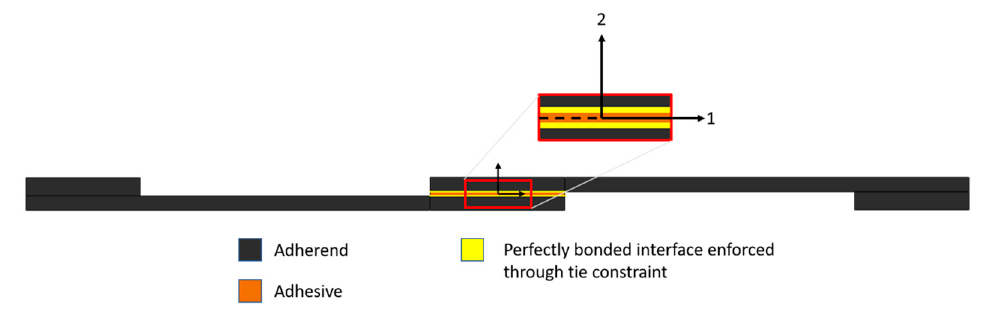
Figure 6. Single-lap shear modeled using plane strain elements in ABAQUS. A tie-constraint simulates a perfect bond between the adherend and adhesive.